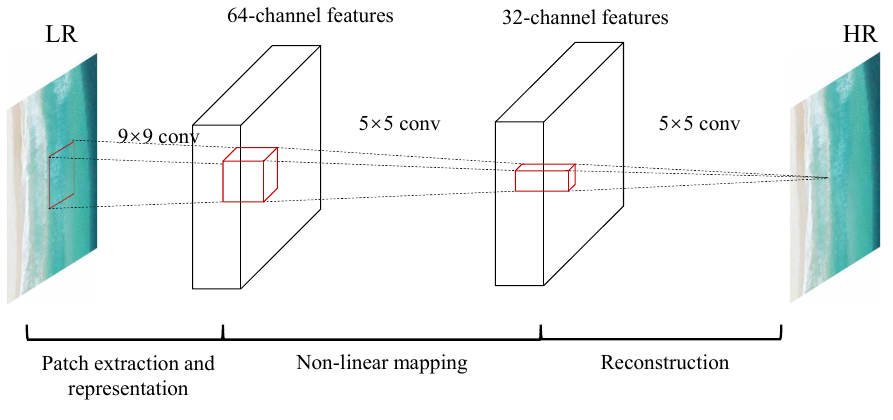
Figure 3. The network structure of SRCNN